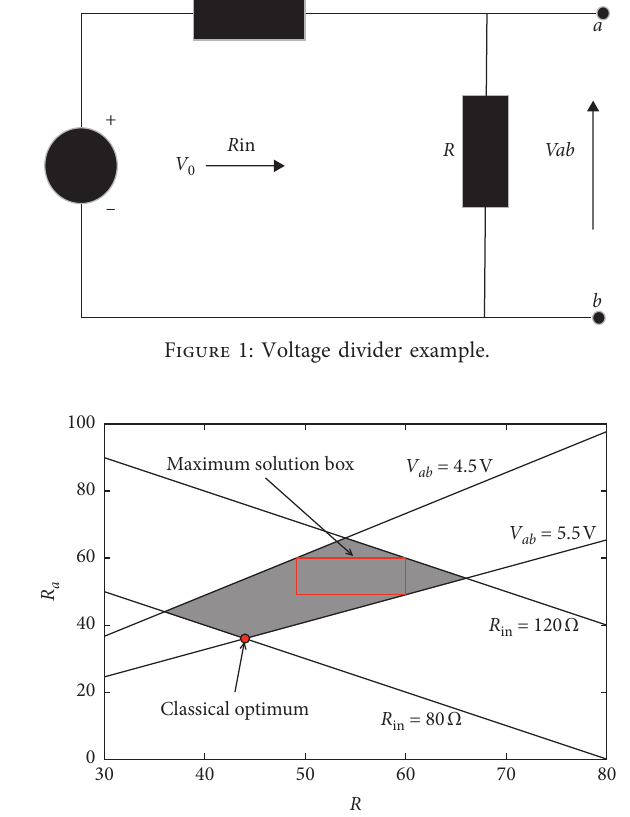
Figure 2: The complete solution space (gray region) and the solution box with the largest volume (region delimited by red lines).